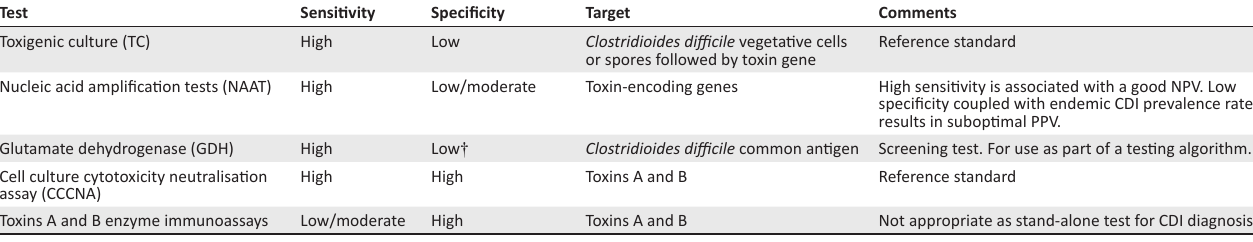
TABLE 2: Summary of available tests for Clostridioides difficile infection